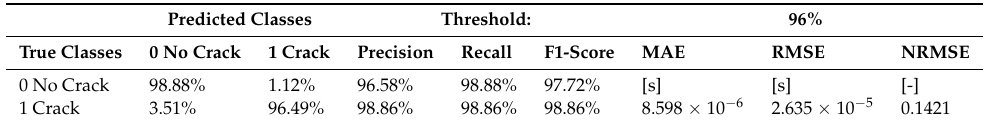
Figure 6. SED trained on seismic data only. ( a ) Crack class probability threshold evaluation in terms of MAE and RMSE; ( b ) onset time predictions in terms of frames on the test set (82 seismic data) for optimal threshold equal to 96%. Table 2. Confusion matrix and classification metrics for SED trained on seismic data only, tested on the seismic test set (82 earthquake